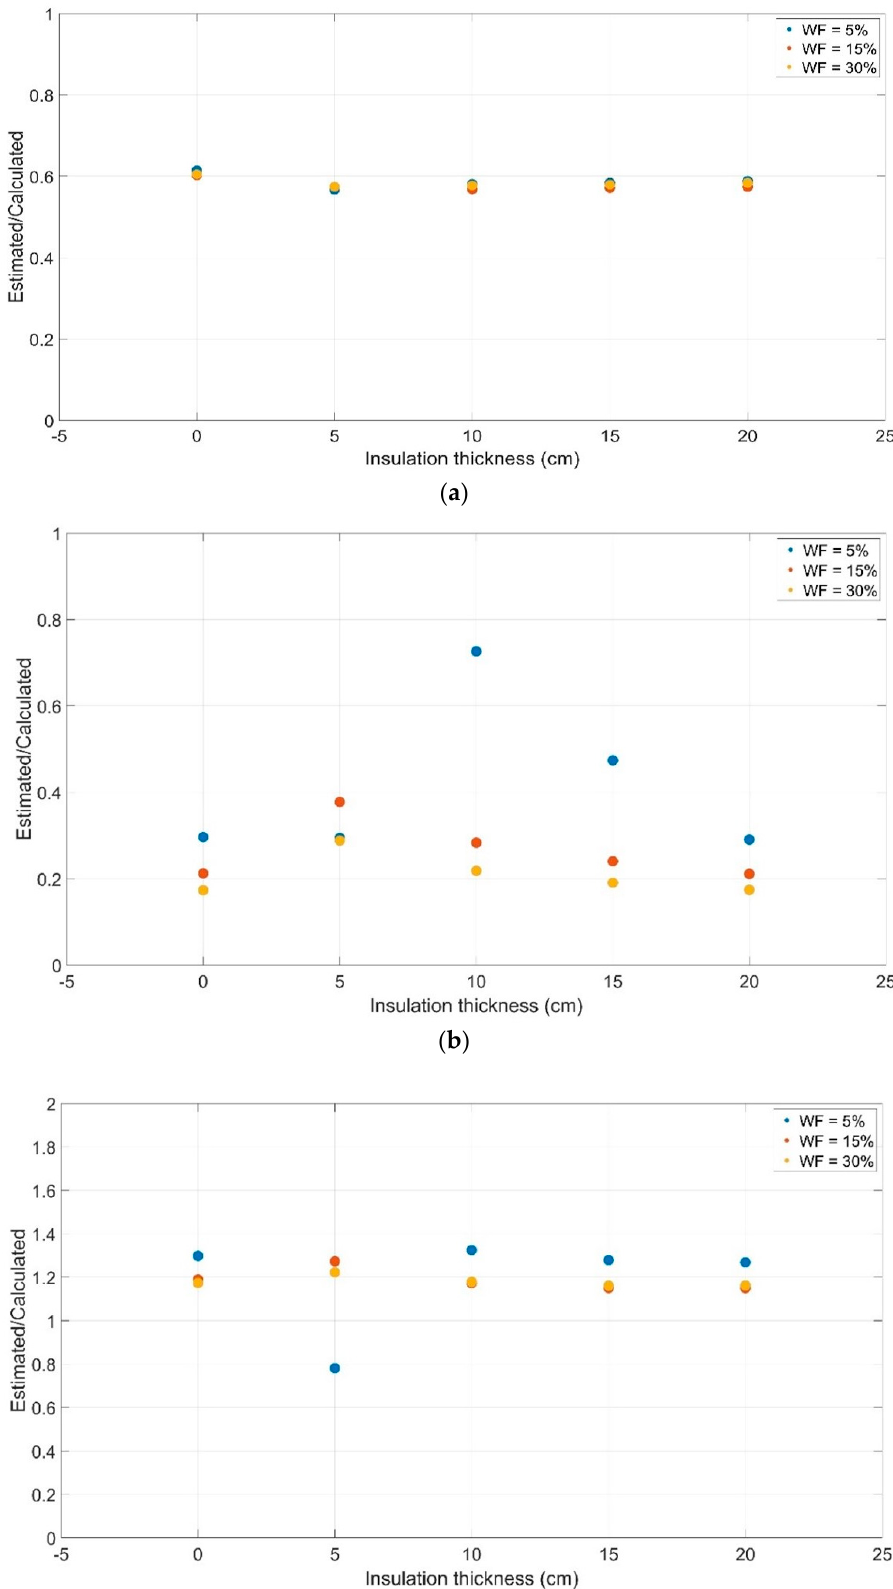
Figure 14. Estimated/calculated ratio of thermal capacitances for various WF values and insulation layer thicknesses: ( a ) internal mass C 1 ; ( b ) envelope C 2 ; ( c ) floor C 3 .